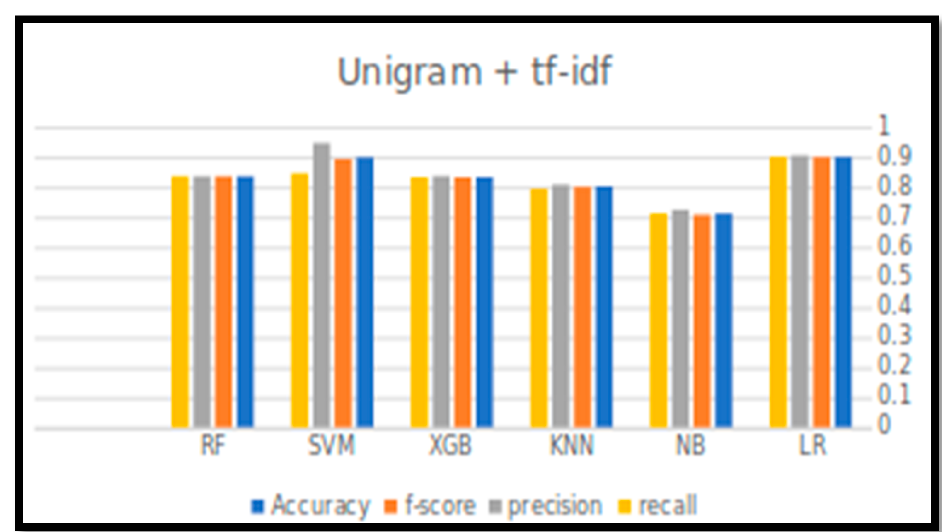
Figure 3. Performance measure results for all classification algorithms with unigram TF-IDF.